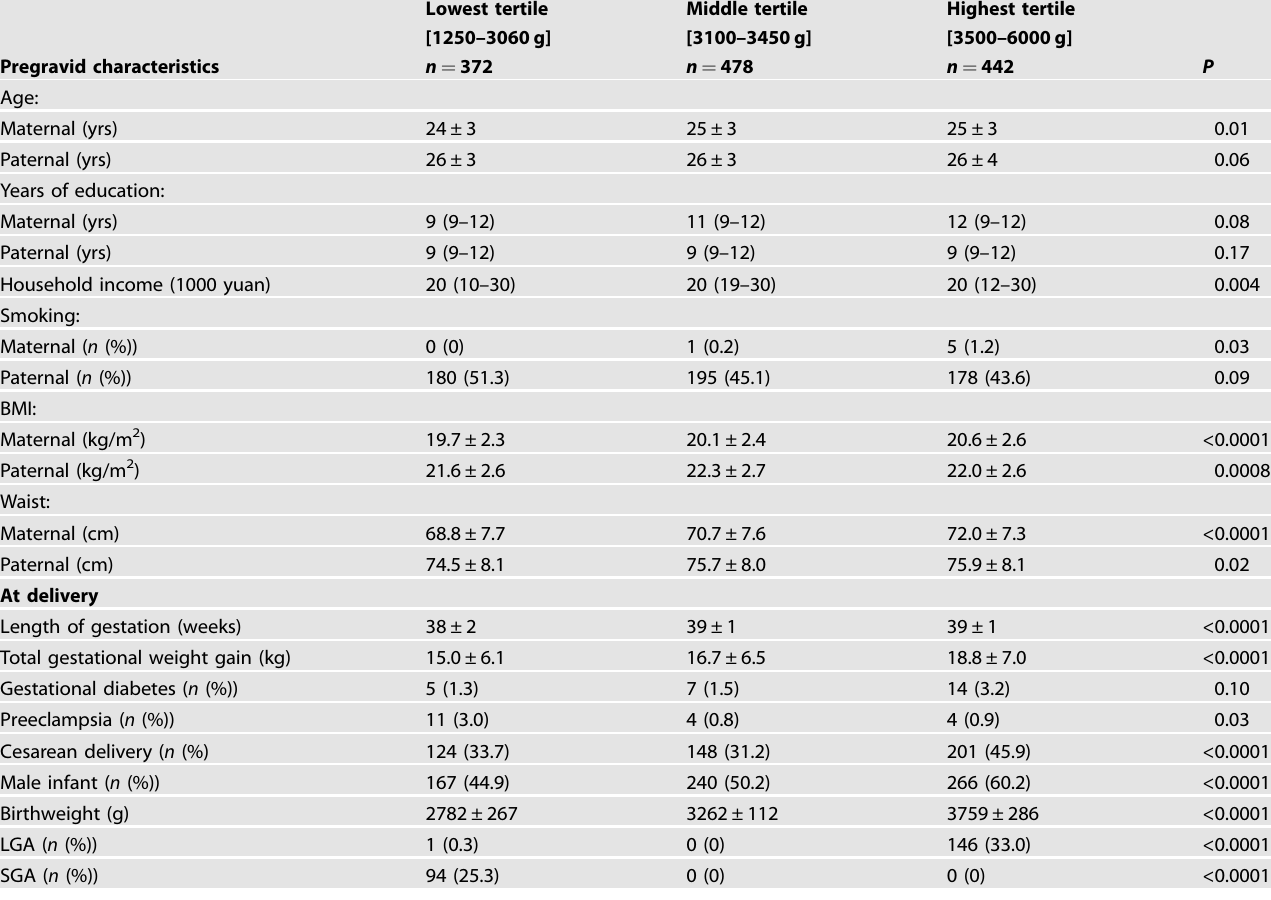
Table 1. Characteristics of study population before pregnancy and at delivery, strati fi ed by tertile of infant birthweight. Continuous data are presented as mean ± SD (if normally distributed) or median followed by interquartile range in parentheses (if